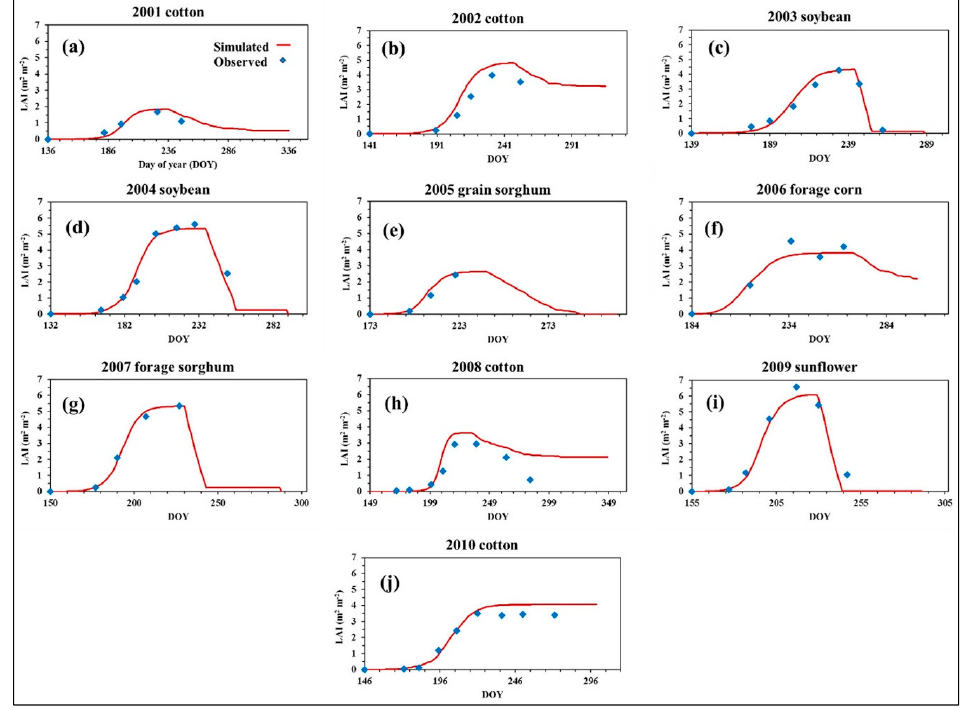
Figure 6. Simulated leaf area index (LAI) under the auto-irrigation scenario of 36 mm soil water deficit trigger compared to measured LAI for crops under the irrigated lysimeter field from 2001 to 2010.